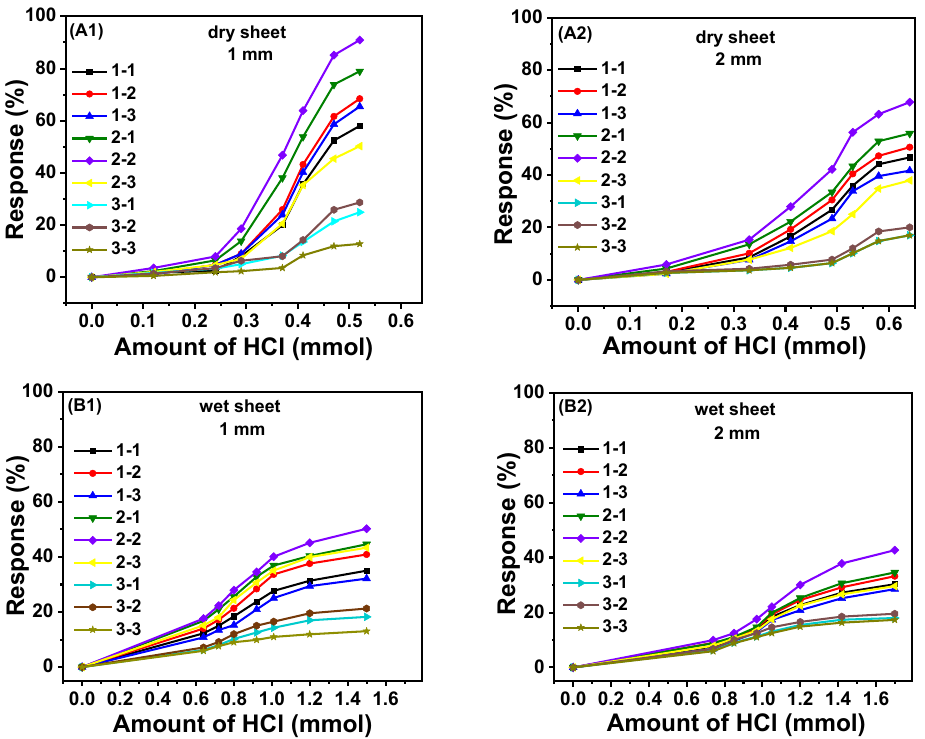
Figure 5. The response of dry and wet cryogel sheets with two thickness ( A1 : dry, 1 mm, A2 : dry, 2 mm; B1 : wet, 1 mm, B2 : wet, 2 mm) to adsorbed HCl gas.